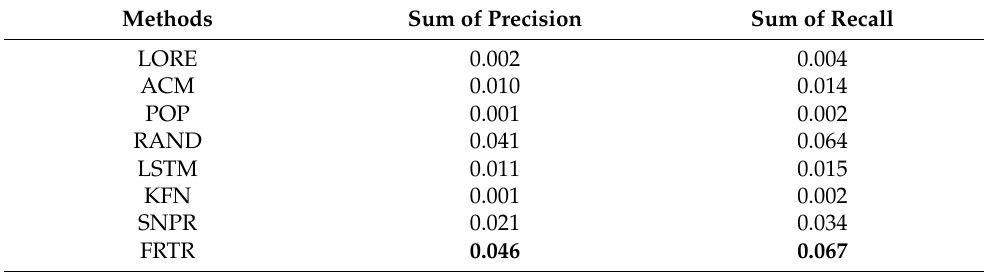
Table 7. Represents the experimental outcomes for the United Kingdom, showing the cold-start issue using novelty.